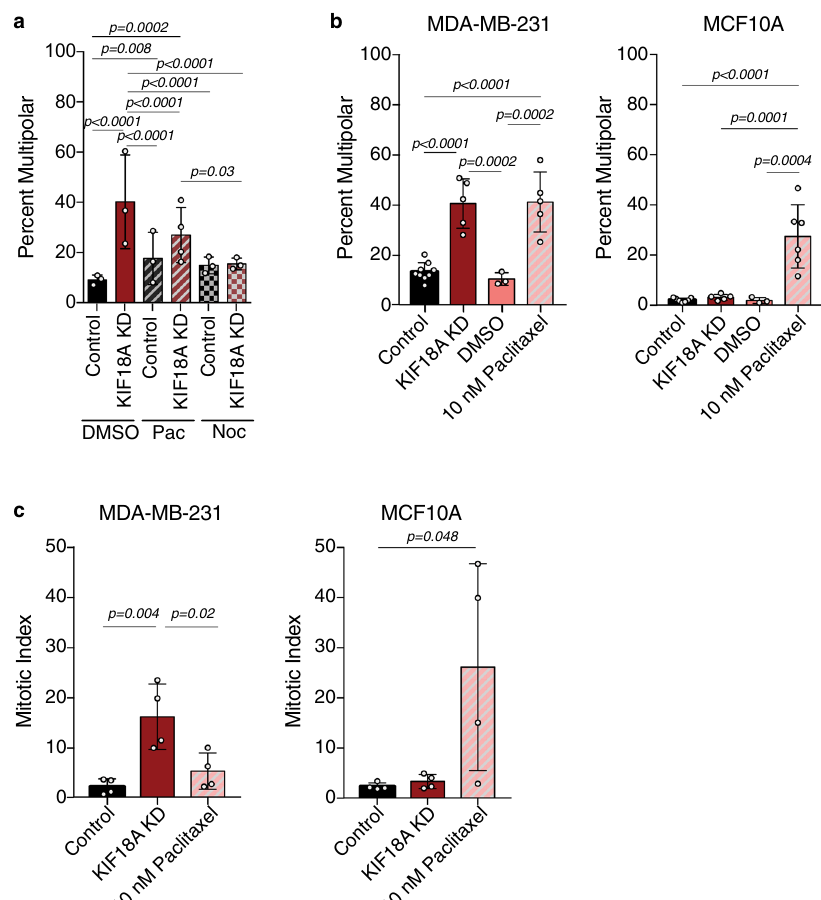
Fig. 6 KIF18A KD-induced centrosome fragmentation is reduced by paclitaxel and nocodazole. a Percent of MDA-MB-231 cells with multipolar spindles in control or KIF18A KD cells treated with either DMSO, 20 nM Paclitaxel (Pac), or 5 μ M Nocodazole (Noc) for 3 h. n = 151 (control KD + DMSO), 263, (KIF18A KD + DMSO), 189 (control KD + pac), 218 (KIF18A KD + pac), 155 (control KD + noc), and 158 (KIF18A KD + noc) cells from three independent experiments. Data were analyzed via a two-sided Chi-square test. b Percentage of mitotic cells with multipolar spindles in fi xed MDA-MB-231 or MCF10A after the indicated treatments. n = 9 (control KD), 5 (KIF18A KD), 3 (DMSO), and 5 (paclitaxel) independent experimental replicates for MDA-MB-231 cells. n = 7 (control KD), 5 (KIF18A KD), 3 (DMSO), and 6 (paclitaxel) independent experimental replicates for MCF10A cells. Data were analyzed via a two-sided Chi-square test. c Percentage of fi xed MDA-MB-231 and MCF10A cells in mitosis following the indicated treatments. n = 4 independent biological samples for all conditions. Data were analyzed via one-way ANOVA with post hoc Tukey ’ s test for multiple comparisons. All graphs show mean ± SD with individual data points indicated. P values <0.05 from the indicated statistical tests are